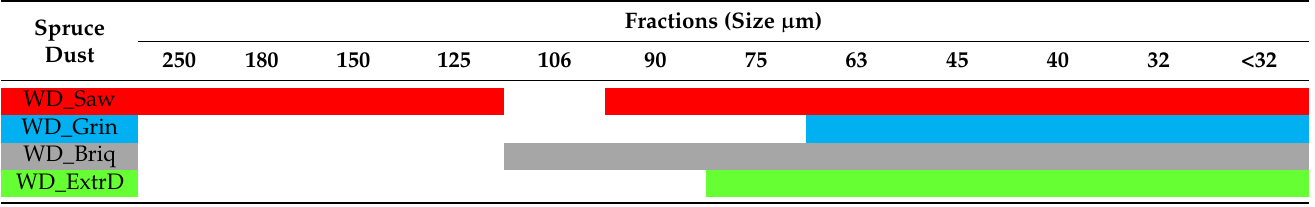
Table 2. Presented interface of used sieves to individual